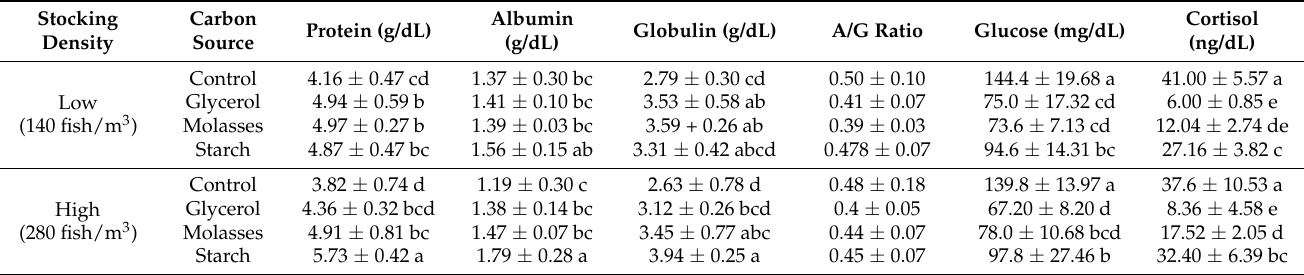
Table 3. Serum biochemical parameters of Nile tilapia juveniles grown at different densities in a conventional intensive culture system and outdoor biofloc technology system (mean ± SD). Stocking